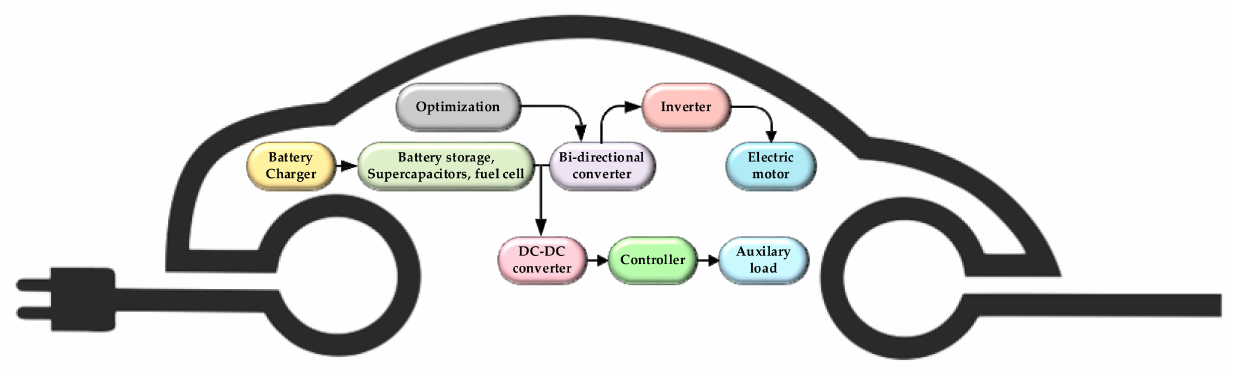
Figure 1. Schematic illustration of the application and interfacing of power electronic converters and ESs in